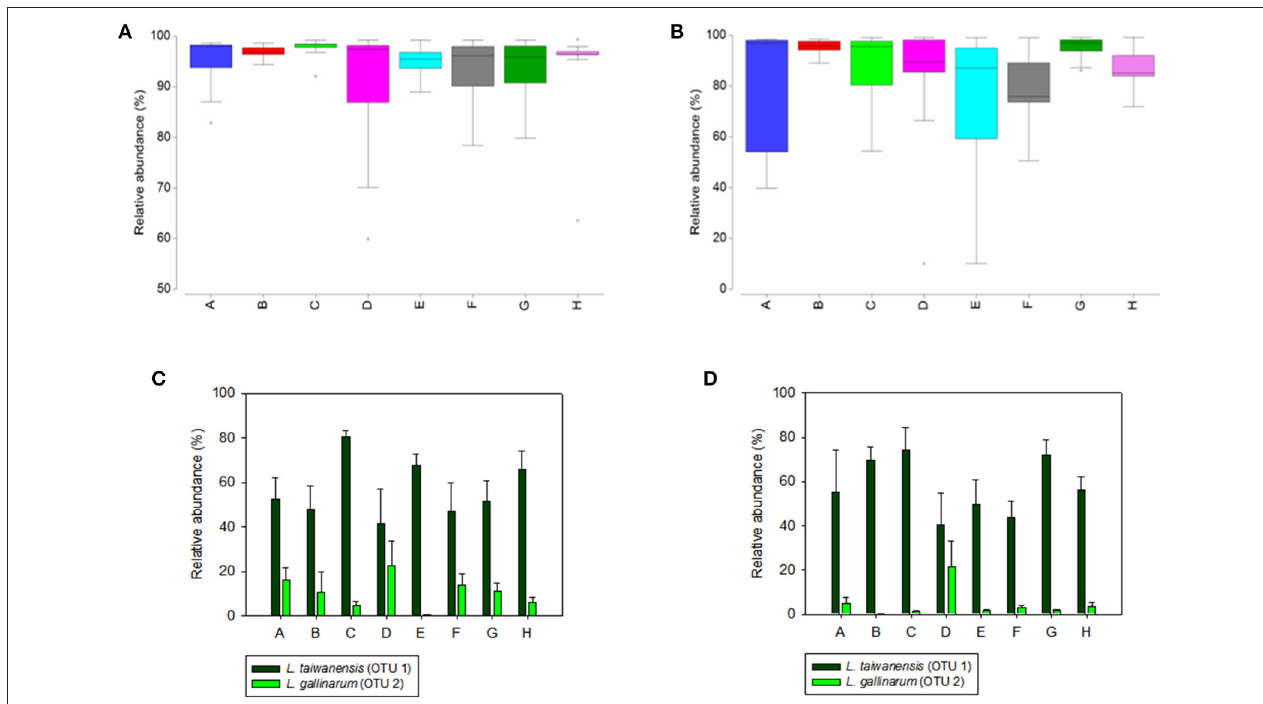
FIGURE 3 | Box-plots showing the relative abundance of the genus Lactobacillus in crop digesta (A) and mucosa (B) across eight dietary treatments ( Table 1 ). The box extends from the lower quartile (25%) to the higher quartile (75%). The line in the box is the median and the whiskers are the minimum and maximum values. The column charts include the relative abundances (Mean, SEM) of the two main species of Lactobacillus , L. taiwanensis (OTU 1), and L. gallinarum (OTU 2) detected in digesta (C) and mucosa (D)